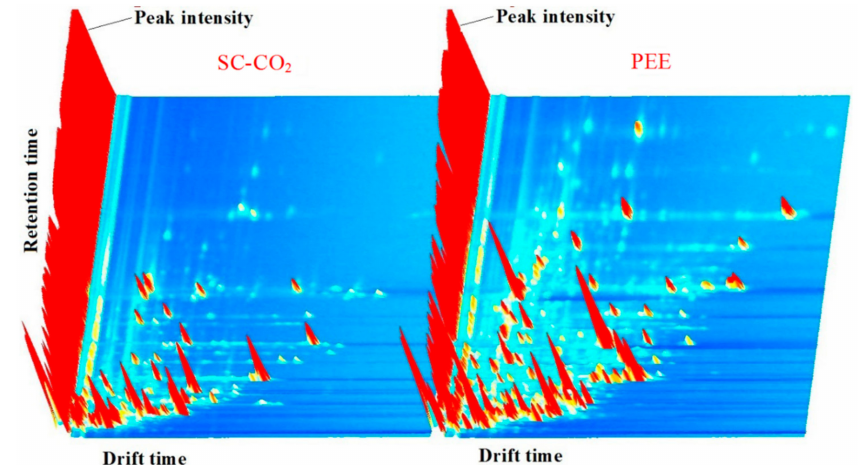
Figure 6. Three-dimensional topographic images of B. dasystachya seed oil obtained by the SC-CO 2 and PEE